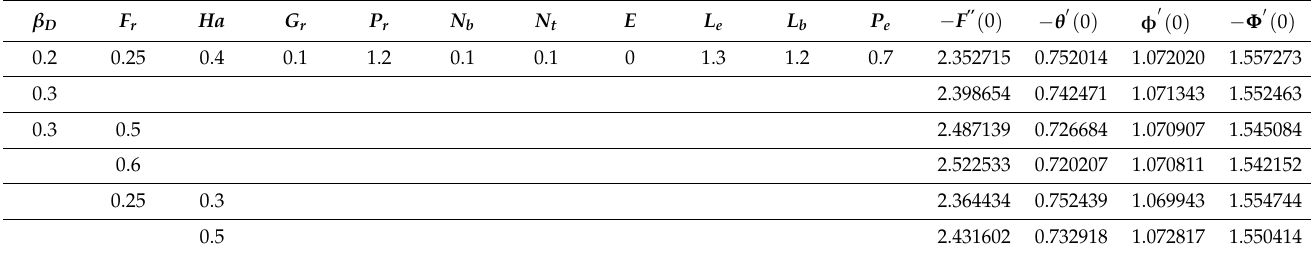
Table 5. Numerical computations of all the physical parameters of interest against different